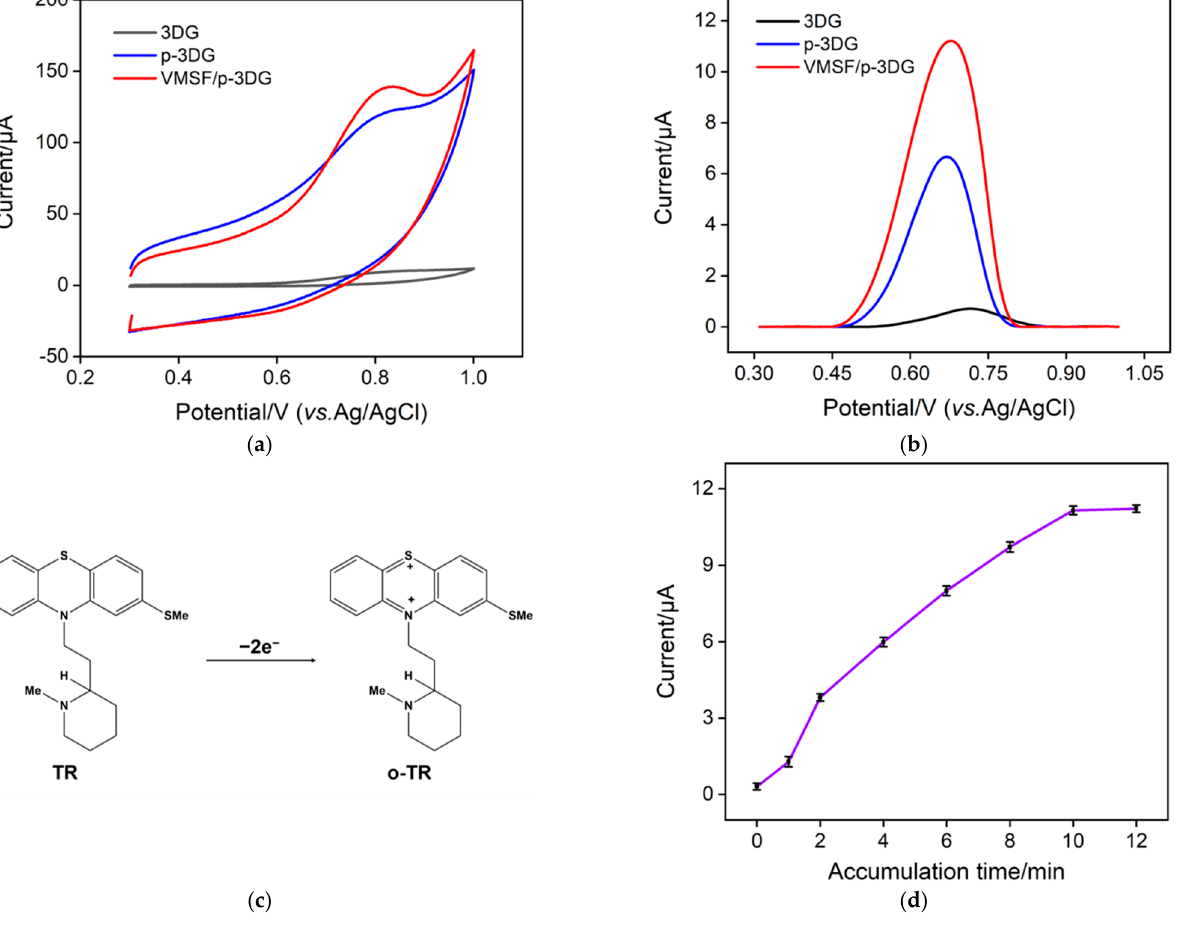
Figure 5. CV ( a ) and the corresponding DPV ( b ) responses gained on 3DG, p-3DG and VMSF/p- 3DG electrodes in 0.01 M PBS (pH 7.4) containing TR (10 μ M). ( c ) Illustration of electrochemical reaction mechanism of TR. ( d ) The oxidation peak currents measured on VMSF/p-3DG towards TR (10 μ M) at different enrichment times.